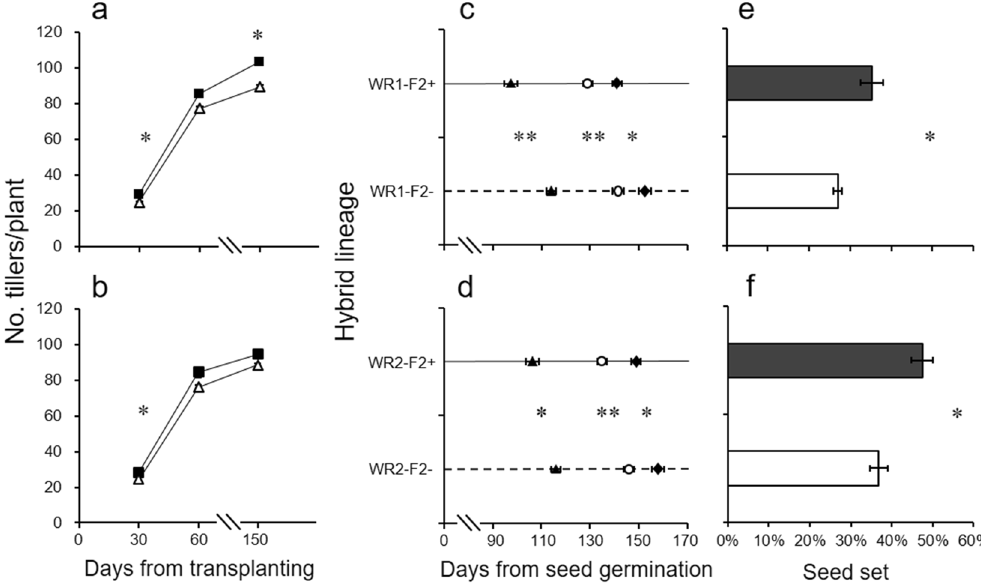
Figure 1. Number of tillers per plant ( a : WR1-F2; b : WR2-F2); flowering time ( c : WR1-F2; d : WR2-F2); and seed set ratios ( e : WR1-F2; f: WR2-F2) of F 2 transgenic (solid squares, dark grey columns) and non-transgenic (empty triangles, white columns) hybrid lineages in pure planting. Solid triangles, empty circles, and solid diamonds (in c and d) indicate days at which 1%, 30%, and 50% plants being flowered, respectively. The comparisons were made between transgenic and non-transgenic F 2 hybrid lineages in pure-planting based on independent t -test (N = 6). Bars represent standard error. * or ** indicates significances at the levels of P < 0.05 or P < 0.01,